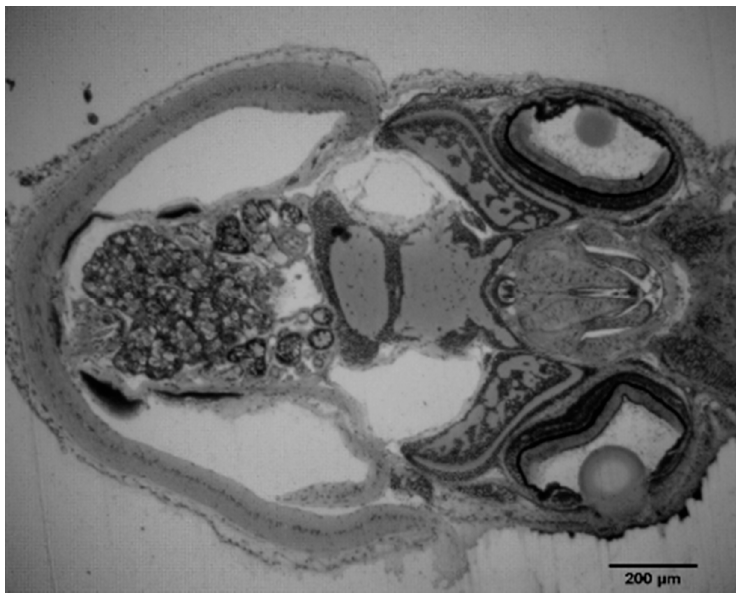
Figure 1. Dorsal histological cut of O. vulgaris paralarvae (control treatment) 15 days after